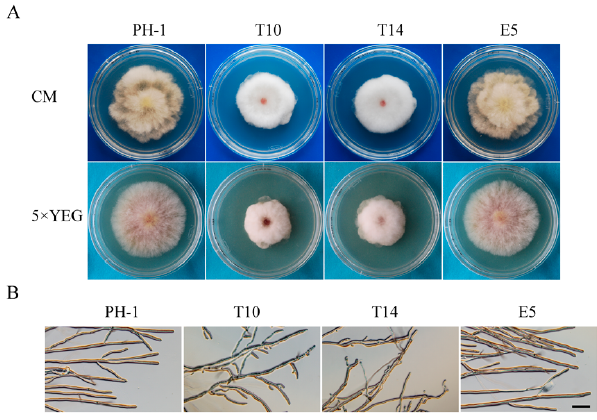
Figure 1. Growth defects of the Δ gil1 mutants. ( A ) Colony of the wild-type (PH-1), Δ gil1 mutants (T10 and T14), and ectopic strain (E5) were grown on complete medium (CM) and 5× YEG (Yeast Extract Glucose) agar plates. Photographs were taken after incubation for three days; and ( B ) edges of PH-1, T10, T14, and E5 colonies formed on 1/2 CM plates were examined for hyphal growth and branching. The Δ gil1 mutants were increased in hyphal branching. Bar = 100 µm. Table 1. Phenotypes of the Δ gil1 mutants in growth, conidiation, and conidia size. Growth Rate (cm/day) a Conidiation Conidium Size (µm) Strain (10 6 conidia/mL) PDA CM 5× YEG Length Width